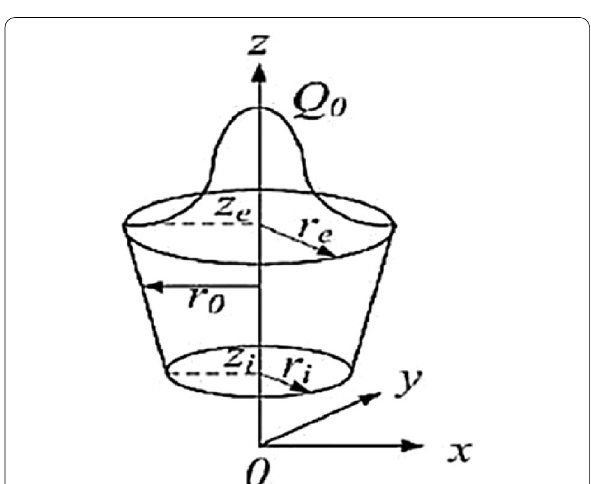
Figure 6 3D Gaussian heat